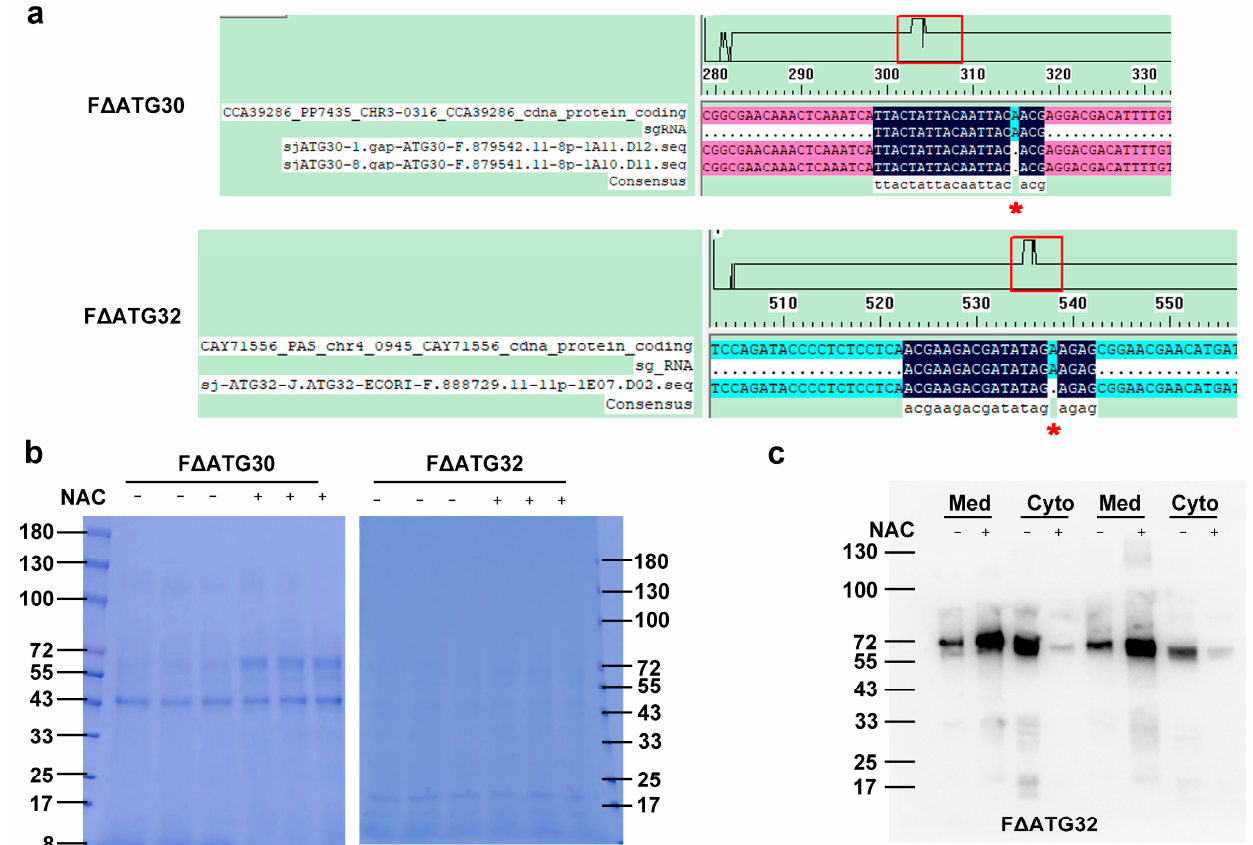
Figure 7. Effect of ATG30 and ATG32 gene disruption on NAC-promoted HSA-pFSH β secretion. ( a ) Shift mutations of ATG30 and ATG32 in strains of F ∆ ATG30 and F ∆ ATG32 were identified by sequencing. Red * represent the deleted base in ATG30 or ATG32 gene of F strain. ( b ) SDS-PAGE analysis of recombinant HSA-pFSH β protein in culture medium of F ∆ ATG30 and F ∆ ATG32 strains treated with 5 mM NAC for 72 h. +: represent culture medium supplemented with NAC, otherwise marked -. ( c ) Western blot analysis of intracellular HSA-pFSH β fused proteins. Med represents HSA-pFSH β protein in culture medium, cyto represents intracellular HSA-pFSH β